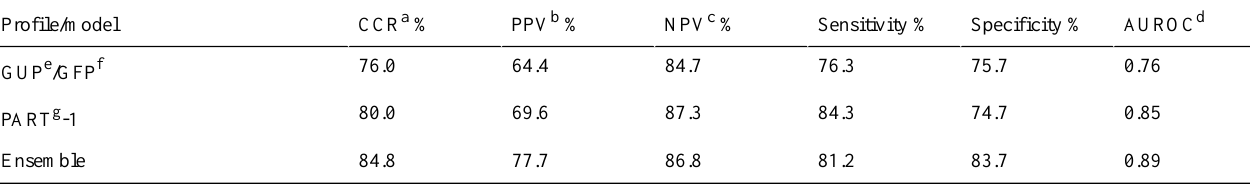
Table 3. Classification accuracy of genetically unfavorable profile/genetically favorable profile (previous study) and models obtained (this study). This analysis was performed on the 104 patients without missing values for any of the genes IFNL3, HLA-B, HLA-C, and